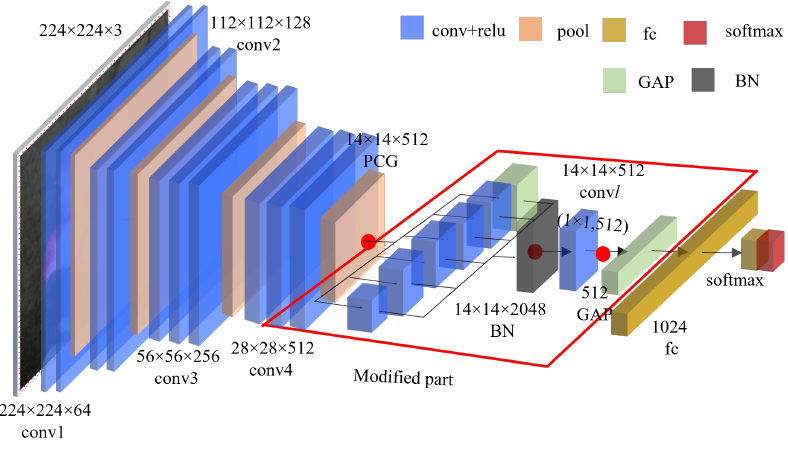
Figure 4. E-VGG16